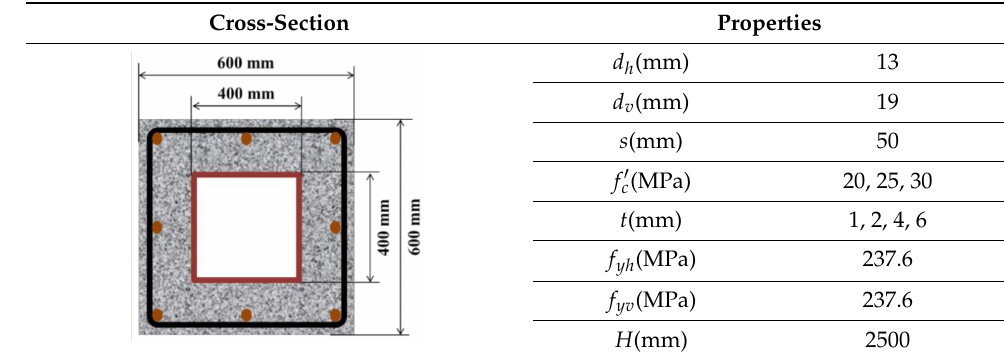
Table 3. Cross-section and specification of the S-S ICH RC